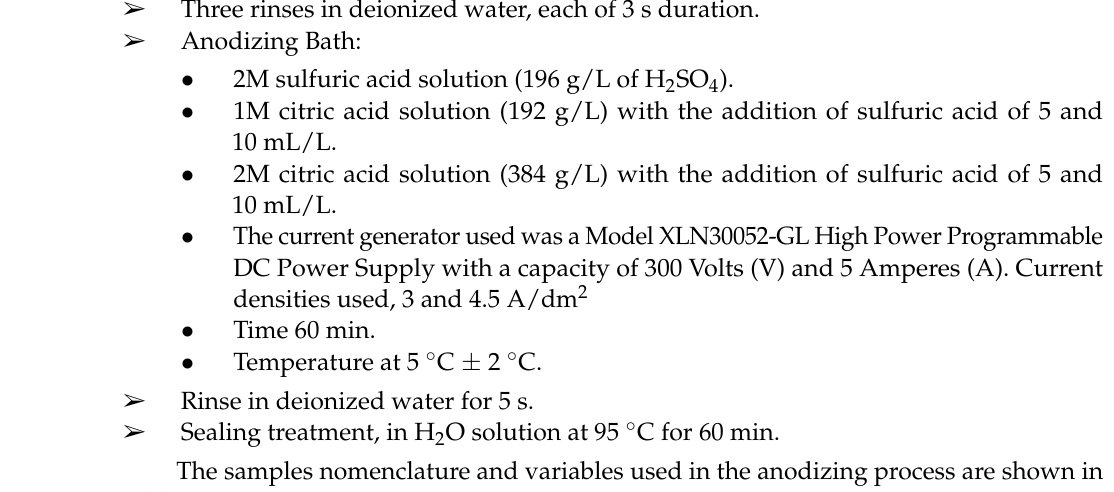
Table 1. Table 1. Process parameters and nomenclature of the AA6061